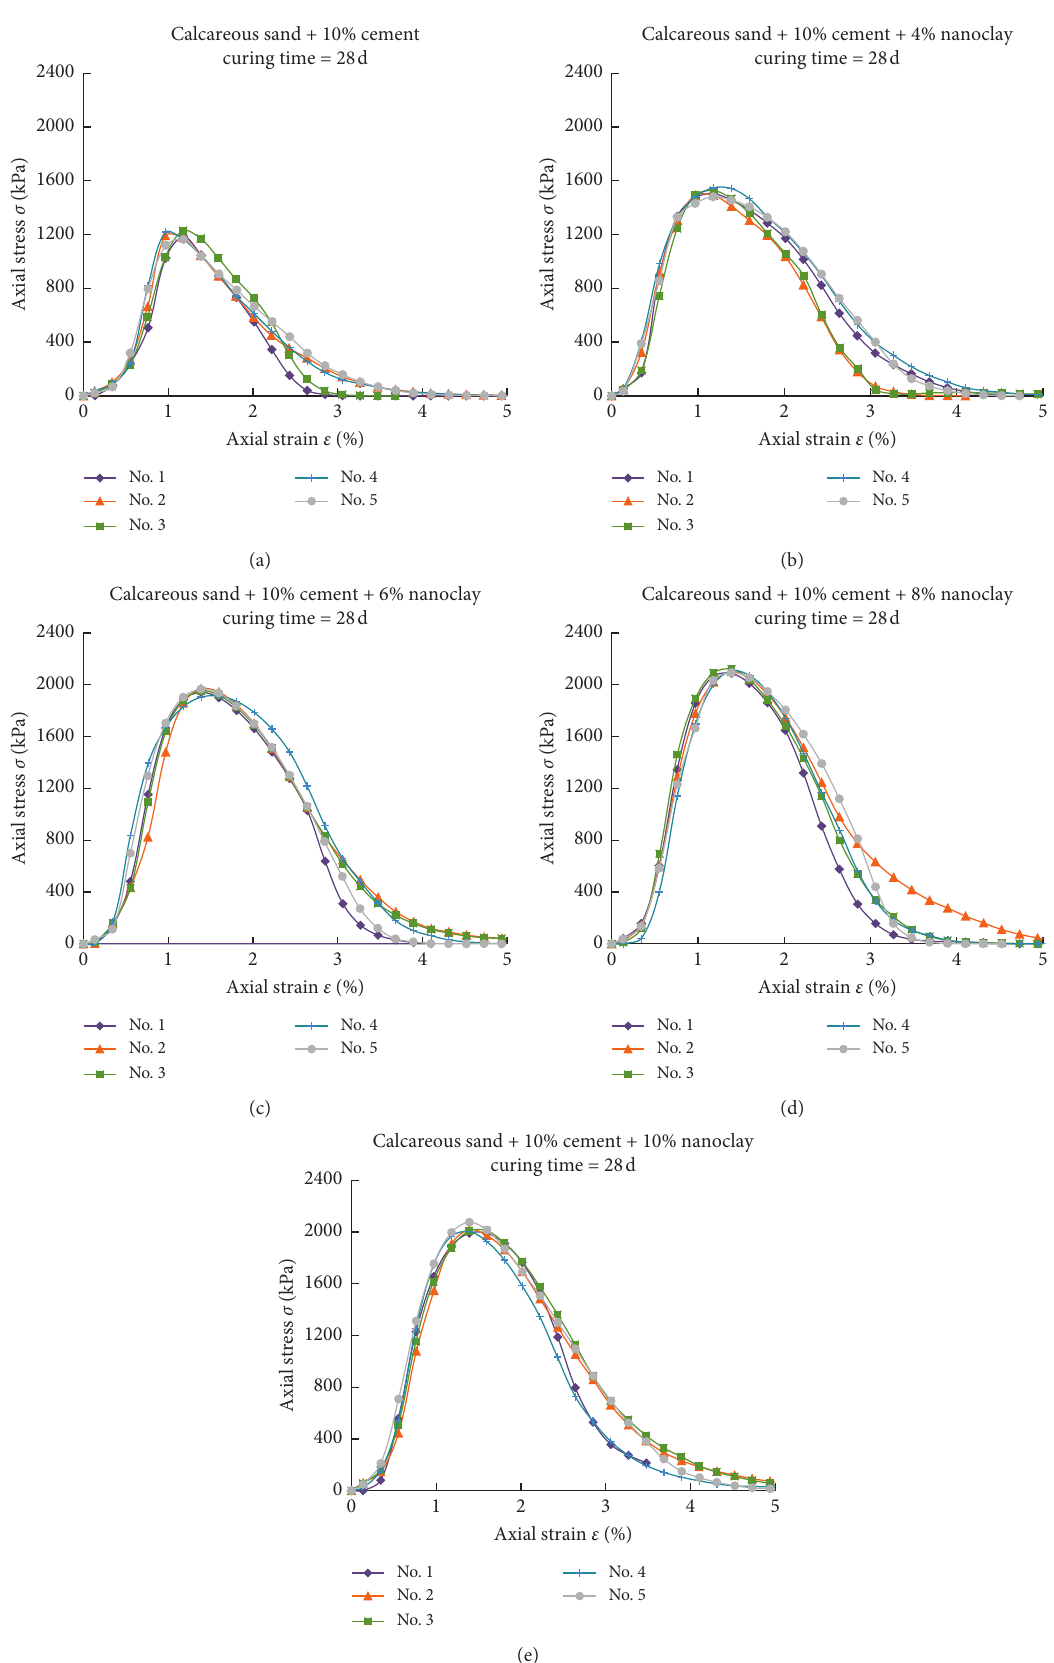
Figure 7: The stress-strain curves of CCS and NCCS on 28d. (a) CCS-28. (b) NCCS-4-28. (c) NCCS-6-28. (d) NCCS-8-28. (e)